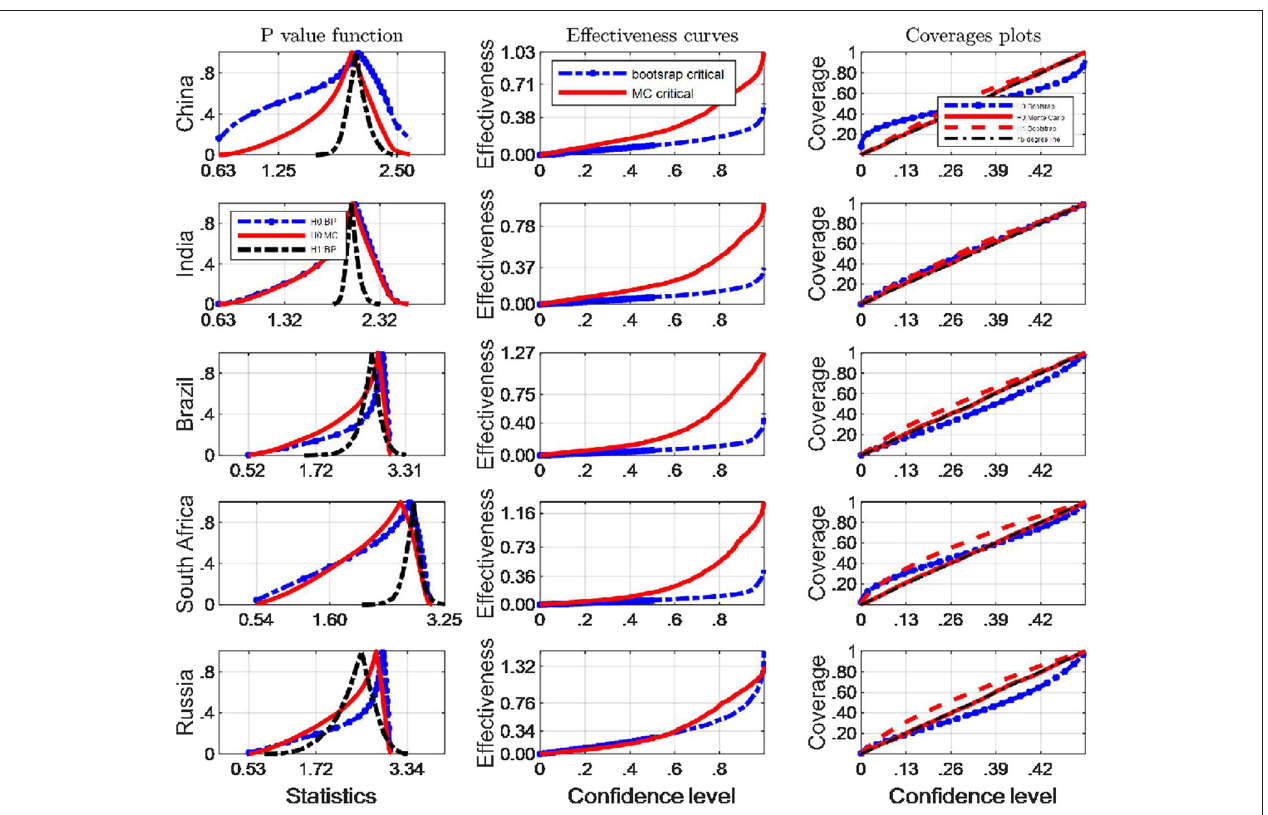
FIGURE 9 | A comparison of confidence intervals of Monte Carlo and counterparts of bootstrap for the Berkes test using BC